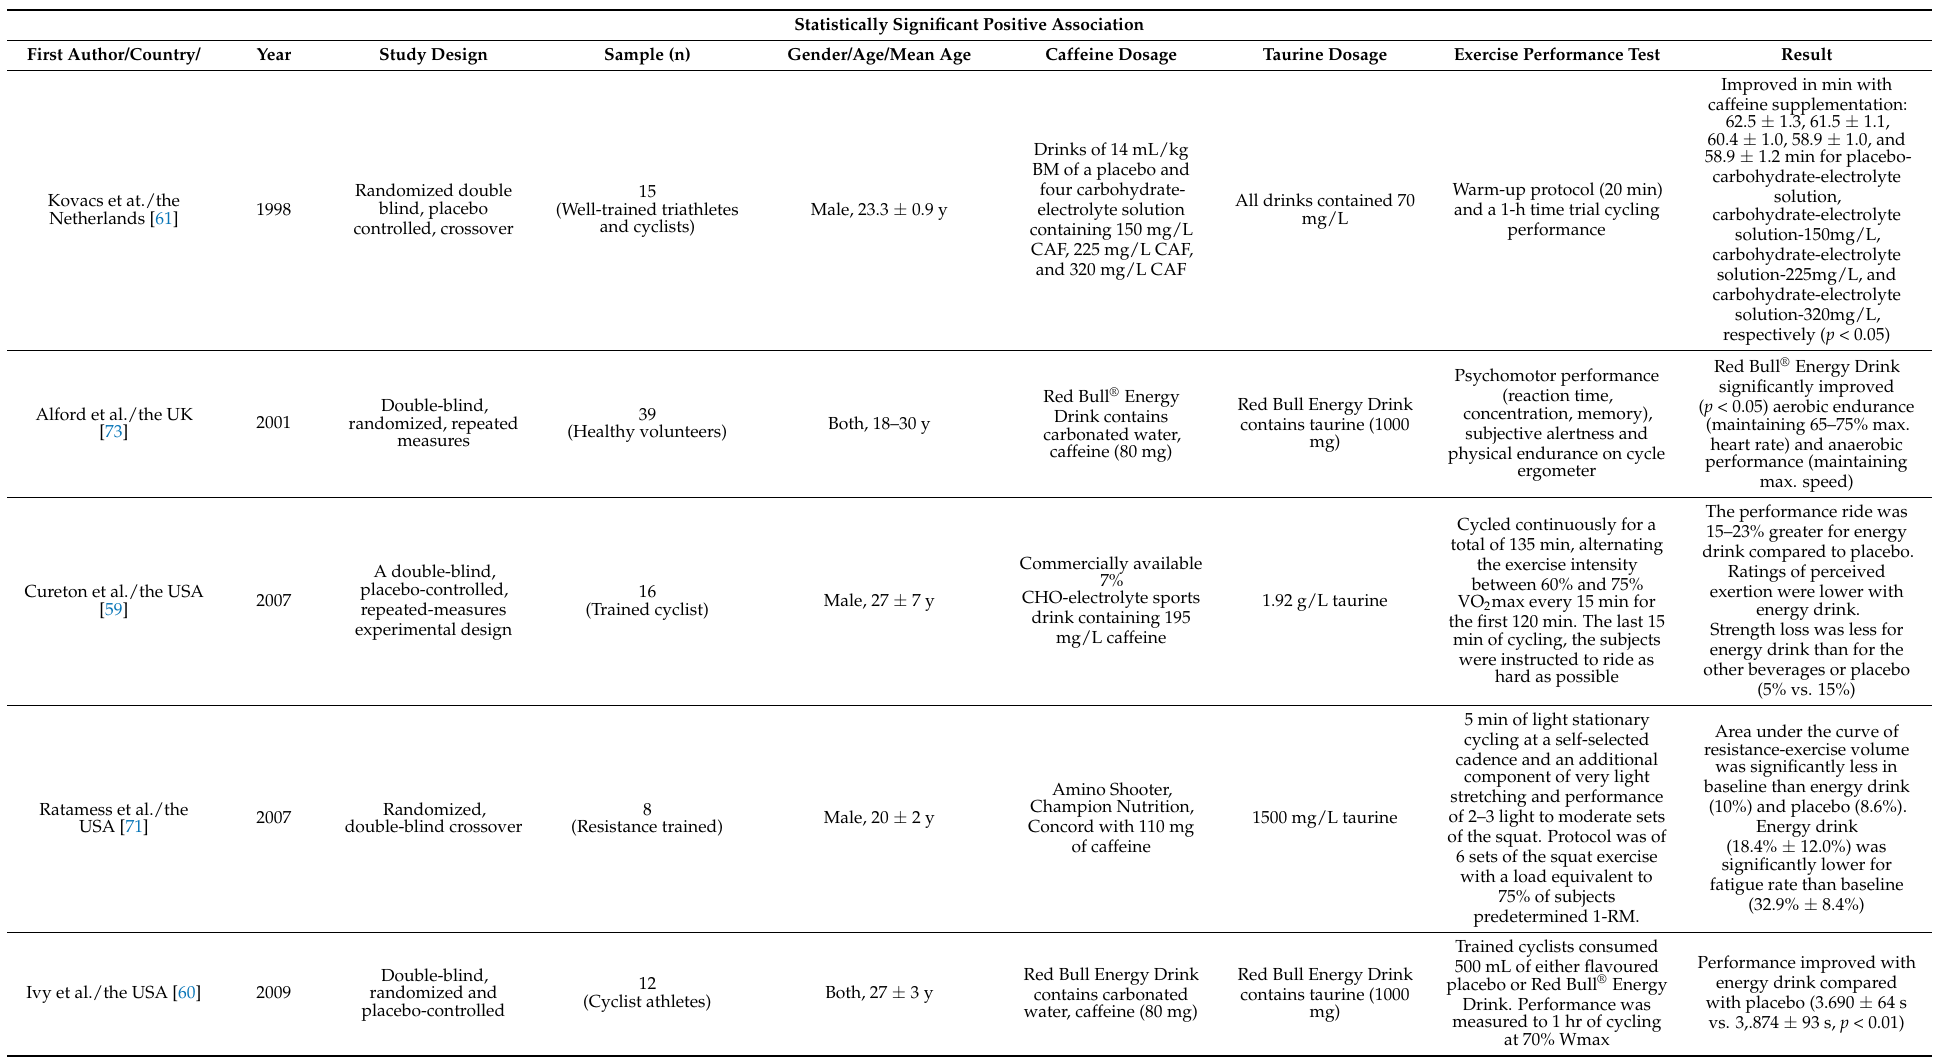
Table 1. Characteristics of studies referring to the association between energy drinks and sport